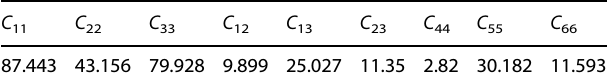
Table 3. Stiffness tensor obtained by DFT in Voigt notation and in the units of